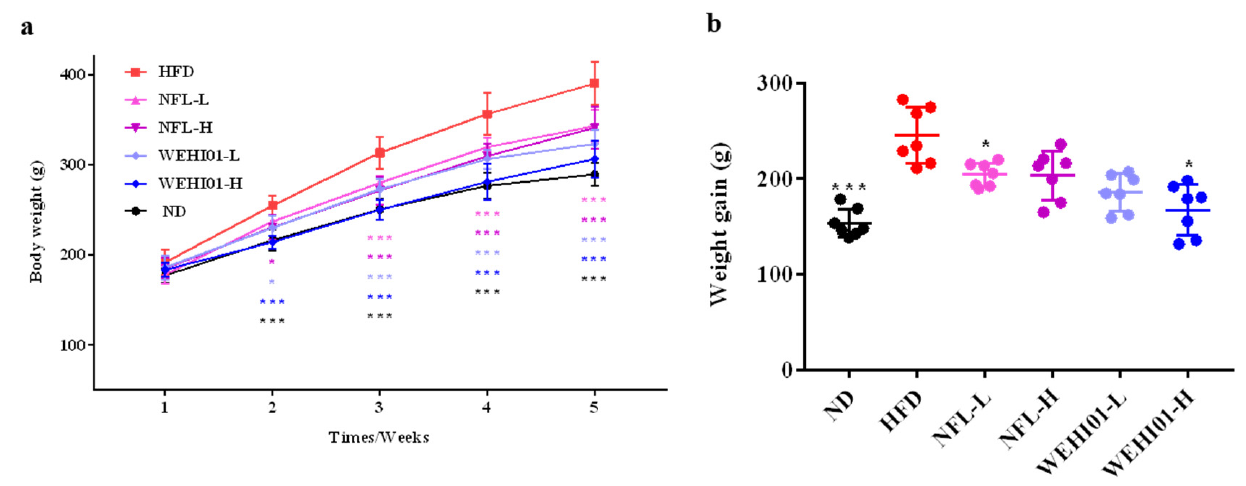
Table 1. Effect of FLLS-WEHI01 on liver, epididymis, kidney, and spleen fat weight as well as food intake in HFD-induced obese mice.